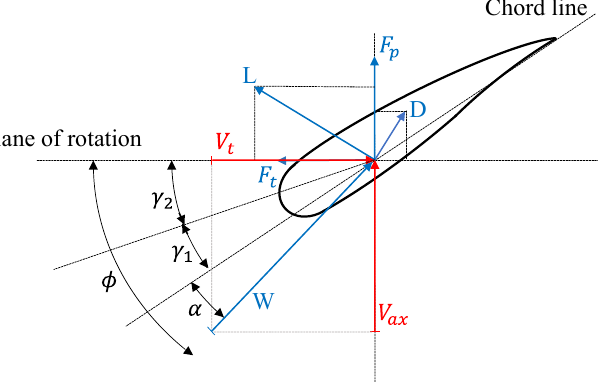
Figure 8. Velocity and force components at the rotor plane